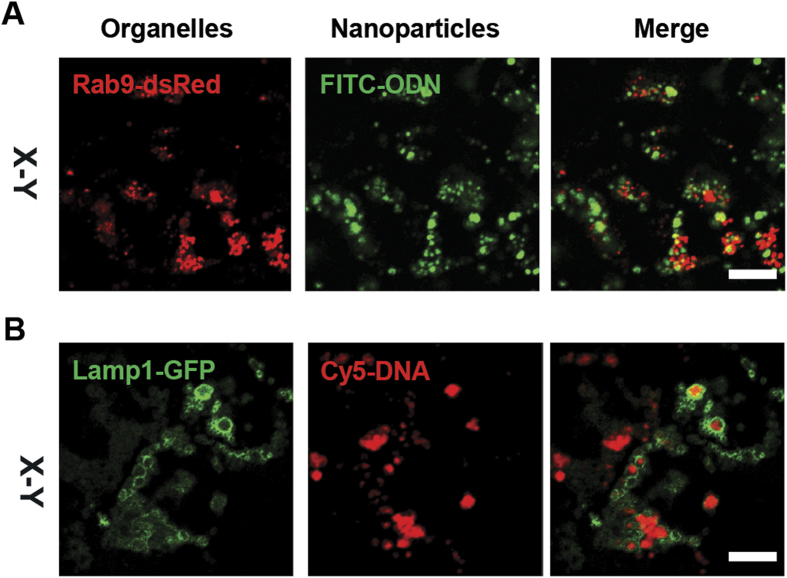
PEI/PIP3 polyplexes localize in late endosomes/lysosomes.(A) MDCK cells that transiently express the fluorescent fusion protein Rab9-dsRed (late endosome), and (B) Lamp1-GFP (late endosome/lysosome) were treated with PEI/PIP3 polyplexes for 72 hours. Polyplexes were fluorescently labeled with Atto495-ODN (A) and Cy5-DNA (B) in order to determine colocalization. Scale bar is 5 μm.